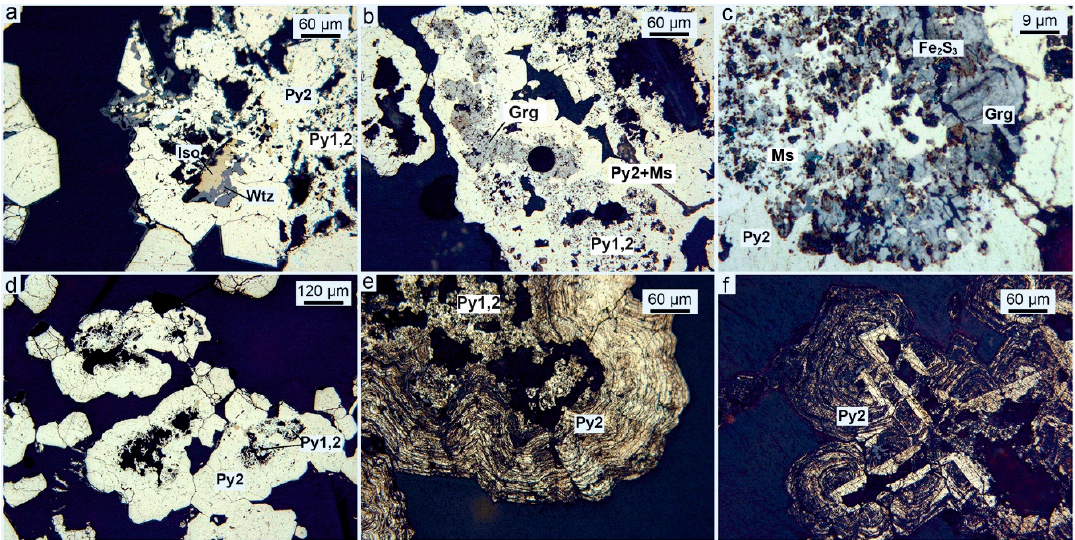
Figure 5. Varieties of pyrite in pyrite microfacies-196 (Sample 37L-196-1 and 37L-196-2). Pobeda-1 hydrothermal field. ( a ) relic inclusions of isocubanite (Iso) and wurtzite-sphalerite (Wtz) in aggregates of subhedral pyrite (Py2); ( b ) relic inclusions of greigite (Grg) with pyrrotite, marcasite (Ms), and phase Fe 2 S 3 aggregates are partly replaced by porous fine-grained pyrite-1,2 (Py1,2) overgrown by subhedral pyrite-2 (Py2); ( c ) greigite (Grg) and phase Fe 2 S 3 (Fe 2 S 3 ) is replaced by pyrite-1,2 (Py2) and marcasite-1 (Ms); ( d ) atoll microtexture of pyrite-2 (Py2) with relic pyrite-1,2 (Py1,2); ( e ) oscillatory coarse-zoned pyrite-2 (Py2) envelops relic fine-grained pyrite-1,2 (Py1,2); ( f ) pyrite pseudomorphs after euhedral crystals of pyrrhotite are overgrown by oscillatory coarse-zoned pyrite-2 (Py2). Reflected light. Some pyrite varieties (e,f) are etched by HNO 3 + CaF 2 .